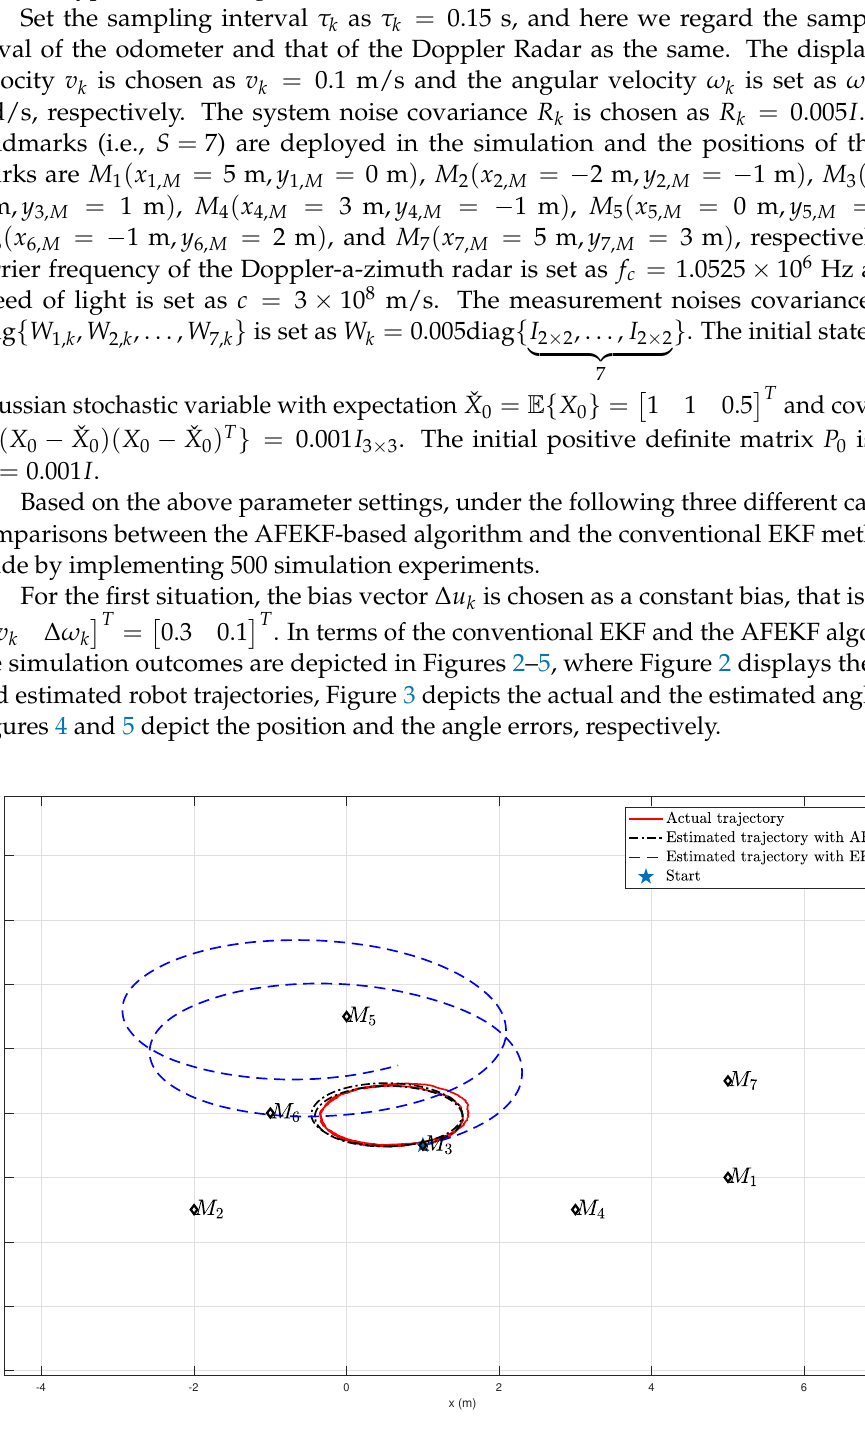
Figure 2. Robot’s trajectory and its estimates under constant